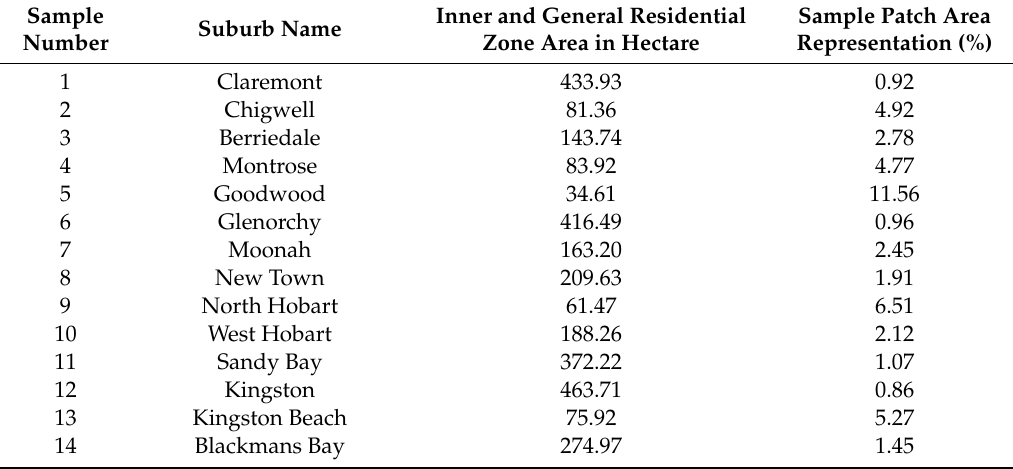
Figure 2. Raster plot (50 × 50 m) of a sample patch image of the Claremont suburb of Glenorchy, Tasmania: ( a ) 2005 satellite image with four bands (red, green, blue and near-infrared) and ( b ) 2016 Google Earth images with three bands (red, green and blue). Table 1. Sample patch area representation in the inner and general residential zone suburbs.